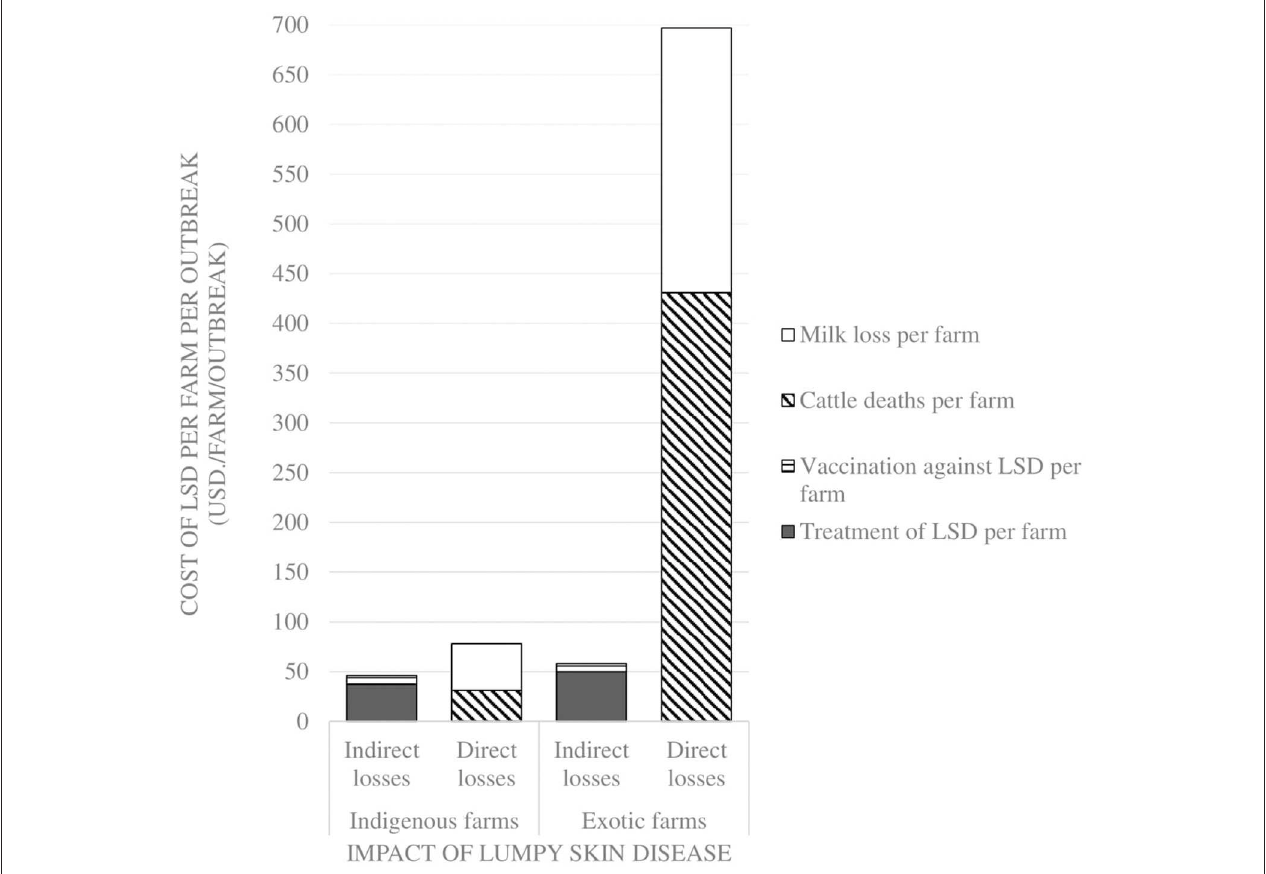
FIGURE 2 | Comparison of the economic impact of Lumpy Skin Disease outbreaks between farms with only indigenous breeds vs. farms with only exotic breeds in Nakuru County,